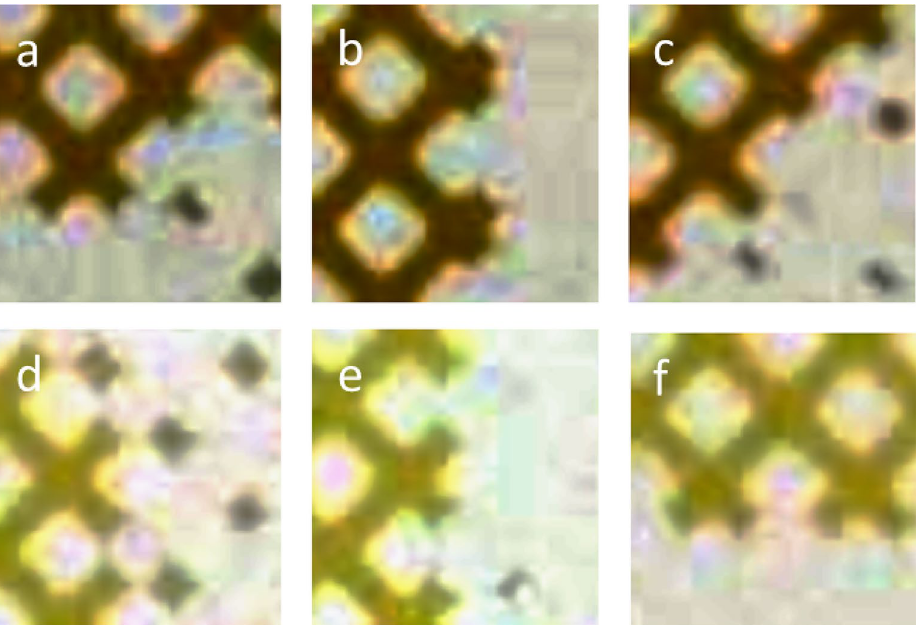
Figure 3. Close-up images with enhanced contrast of the border regions between the remaining oil and brine solution having displaced oil in the porous network for crude oil A at 22 °C ( a ), 60 °C ( b ) and 100 °C ( c ) and crude oil C at 22 °C ( d ), 60 °C ( e ) and 80 °C ( f ).